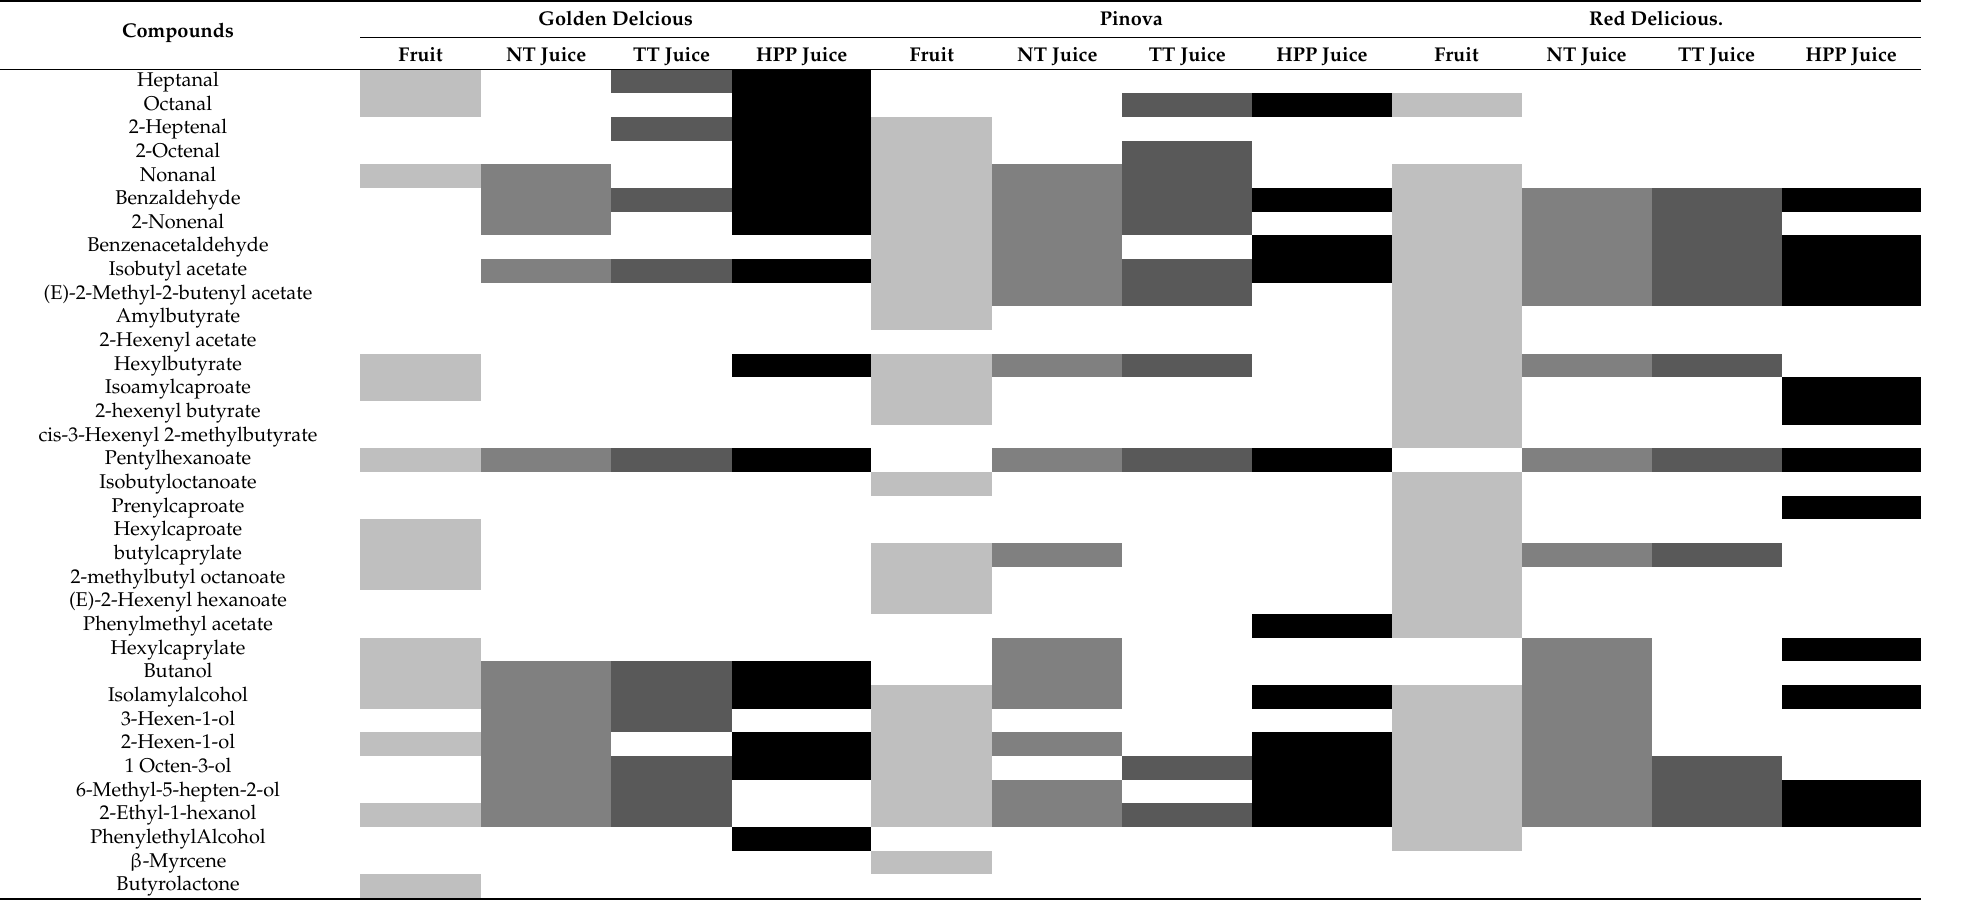
Table 3. Presence/absence of the different aromatic compounds in the apple cultivars’ samples (fruits and juices). Golden Delcious Pinova Red Delicious. Compounds Fruit NT Juice Fruit